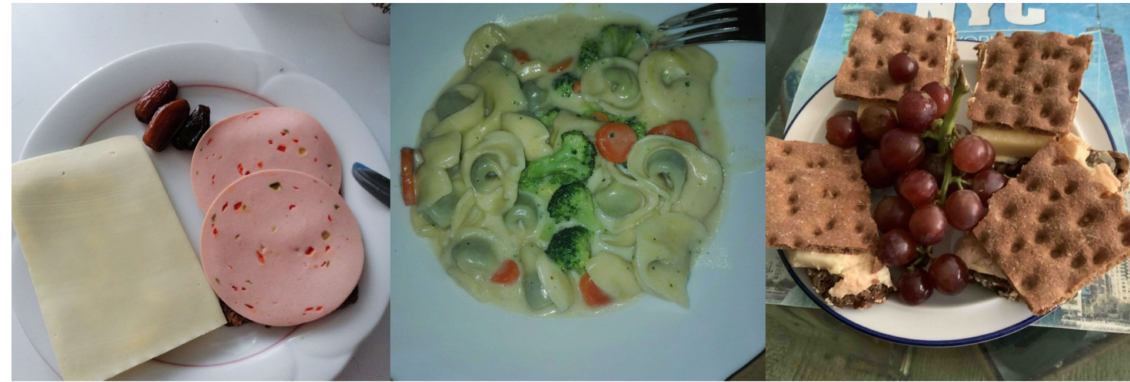
Figure A6. Meal photos at the end of the